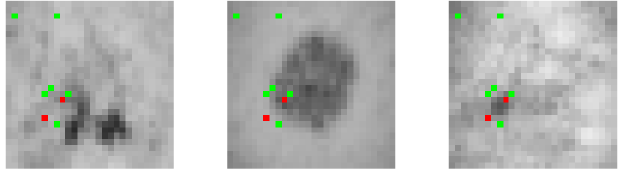
Figure 19. Samples belonging to the “benign” class, activating the same